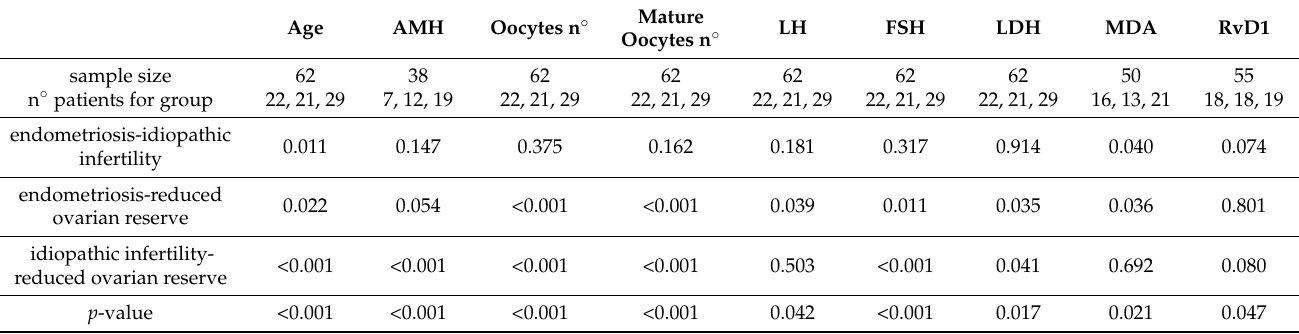
Table 3. p -values for multiple and pairwise comparison between the three groups with different reproductive conditions. Only variables giving rise to p -values less than 0.05, reported in the last row, for the multiple comparison Kruskal-Wallis test are listed in the first row. In the first row, for each variable, the sample size is reported and, in the second row, the number of patients in the endometriosis, idiopathic infertility and reduced ovarian reserve group, respectively. In the inner cells, p -values of the Dunn test for pairwise comparisons. Antimullerian hormone (AMH), oocytes number, mature oocytes number, luteinising hormone (LH), follicle stimulating hormone (FSH), lactate dehydrogenase (LDH), malondialdehyde (MDA), resolvins (RvD1). Mature LH FSH LDH MDA RvD1 Age AMH Oocytes n ◦ Oocytes n ◦